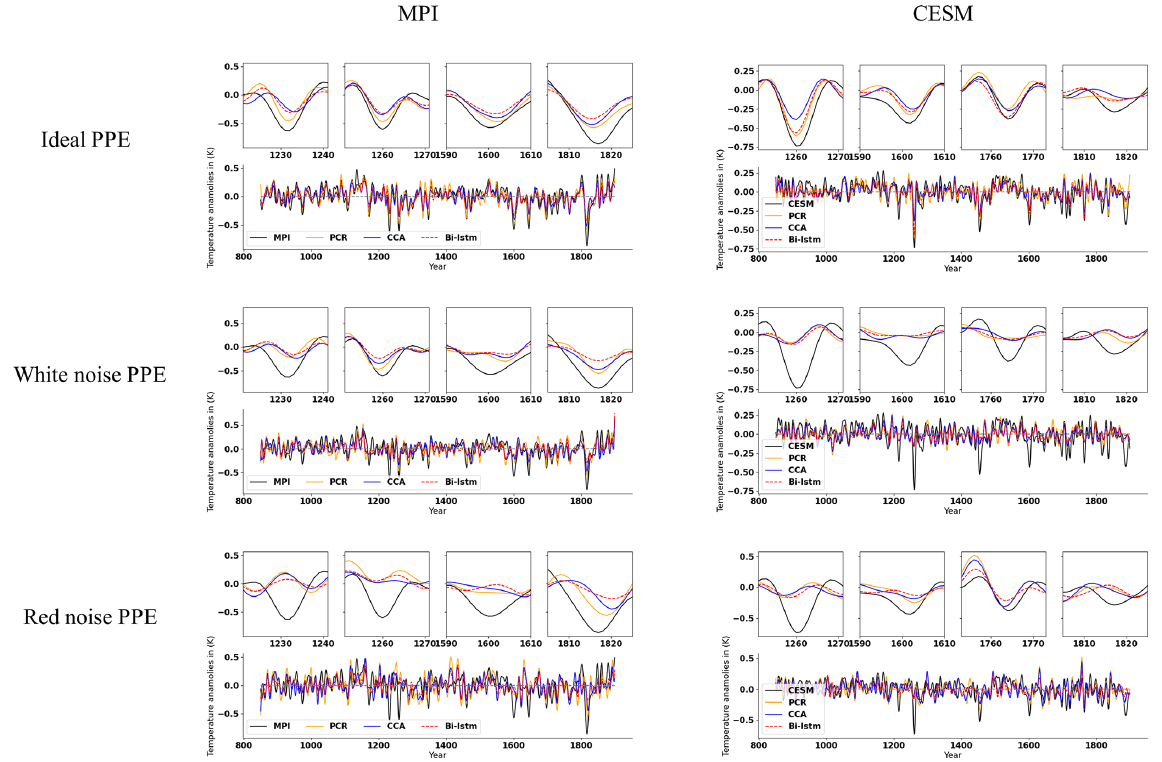
Figure 12. The same as Fig. 11 but for the Atlantic multidecadal variability (AMV) index. Table 2. The cc, SD, and RMSE (K) values during the verification interval for decadal NH mean temperature derived from ideal PPEs. The numbers in parentheses indicate skill statistics of white-noise-contaminated and red-noise-contaminated (italics)